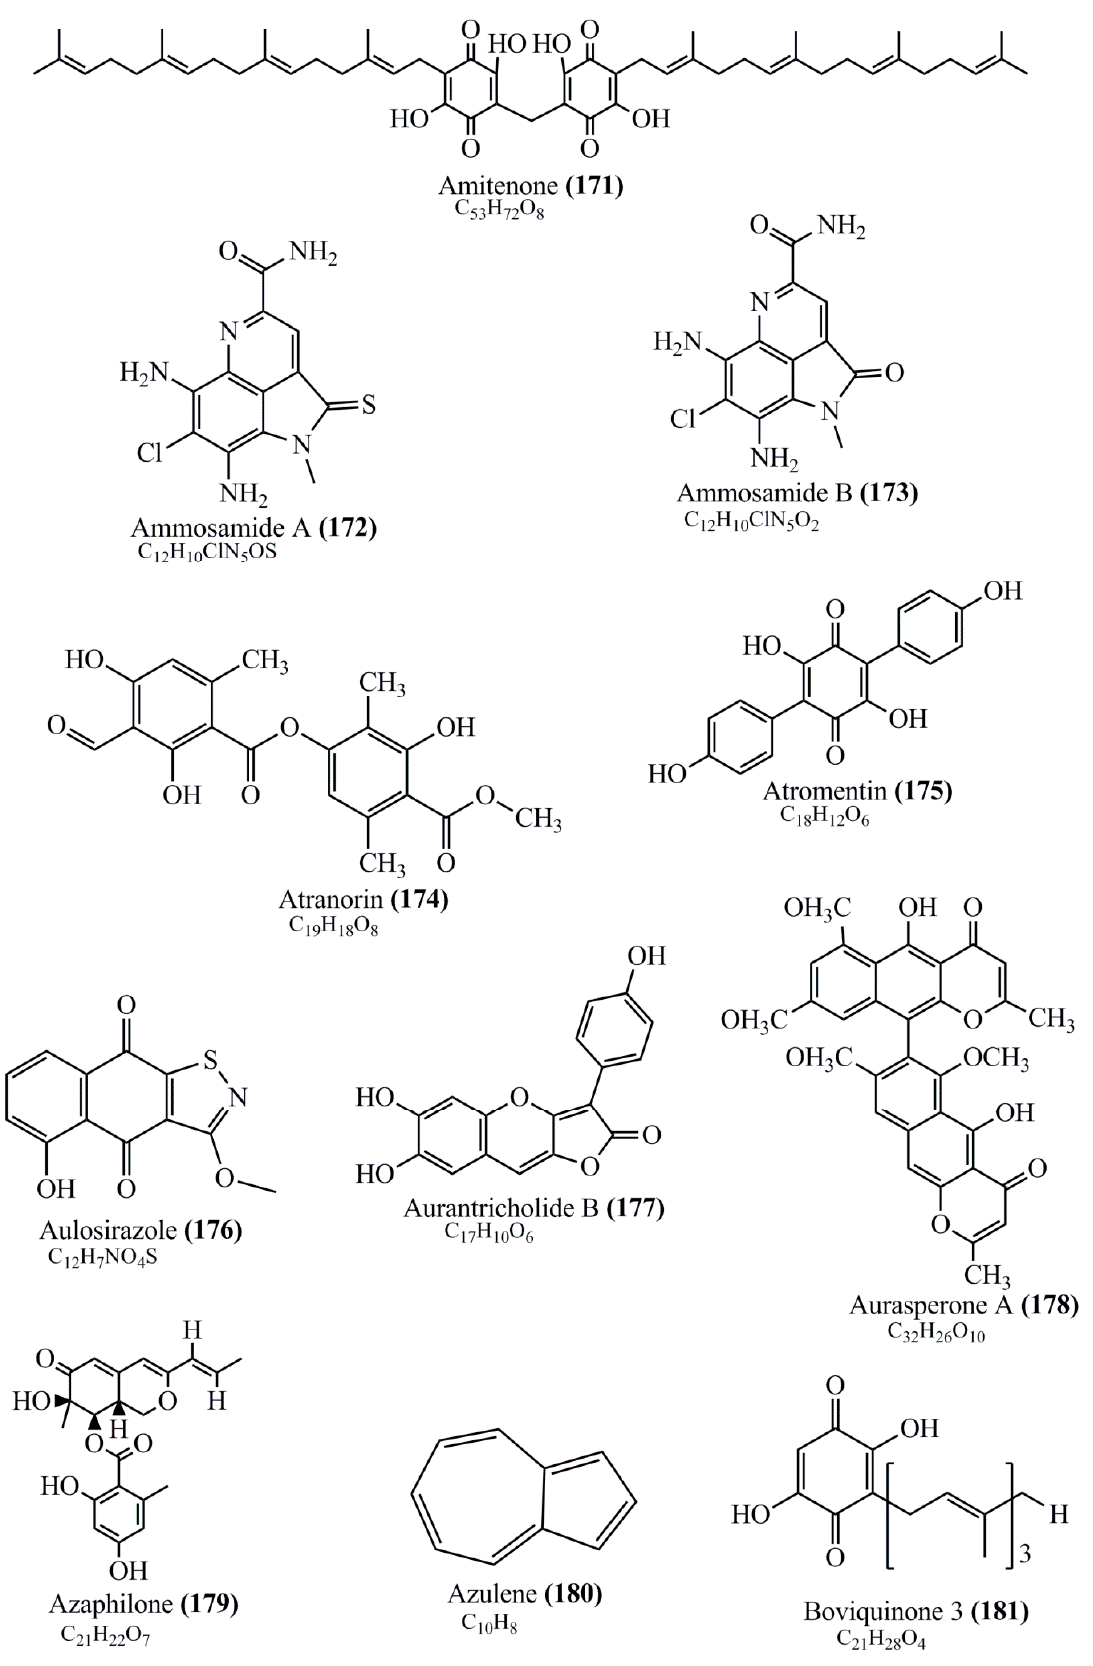
Figure 1. Figure 1. Continued.